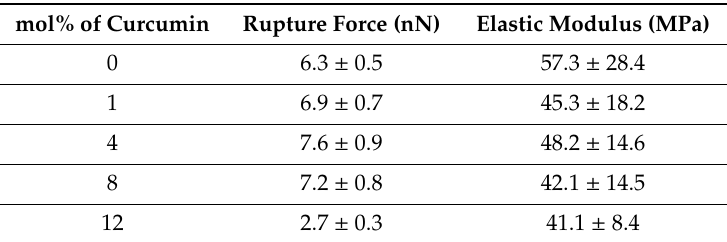
Table 1. Mechanic properties of bilayers containing various amounts of curcumin probed by AFM force spectroscopy (average values calculated from 3 mappings of 1024 force